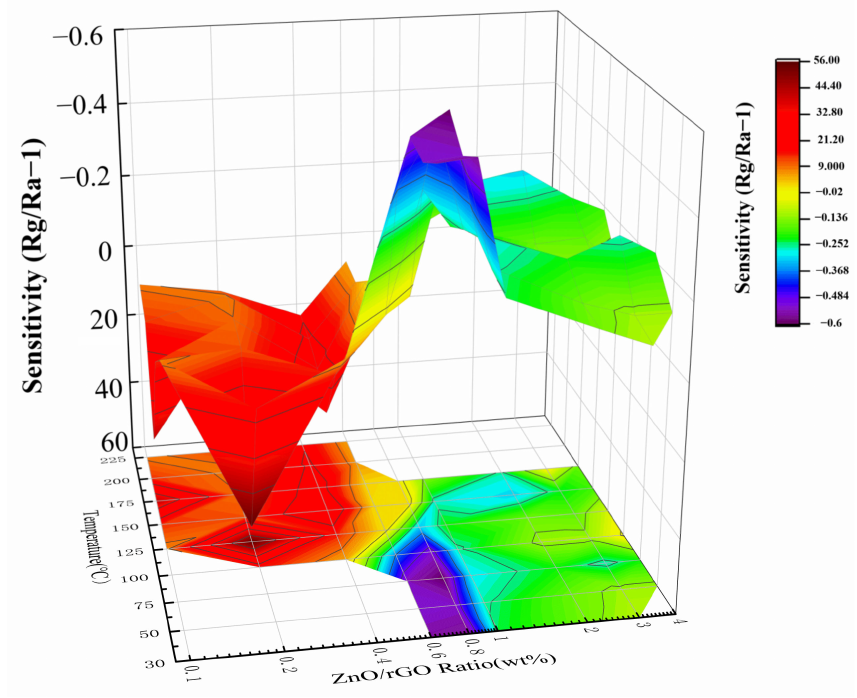
Figure 5. Variation of the sensitivity of the sensors base on the ZnO-x rGO with temperature and addition of rGO toward 4 ppm NO 2